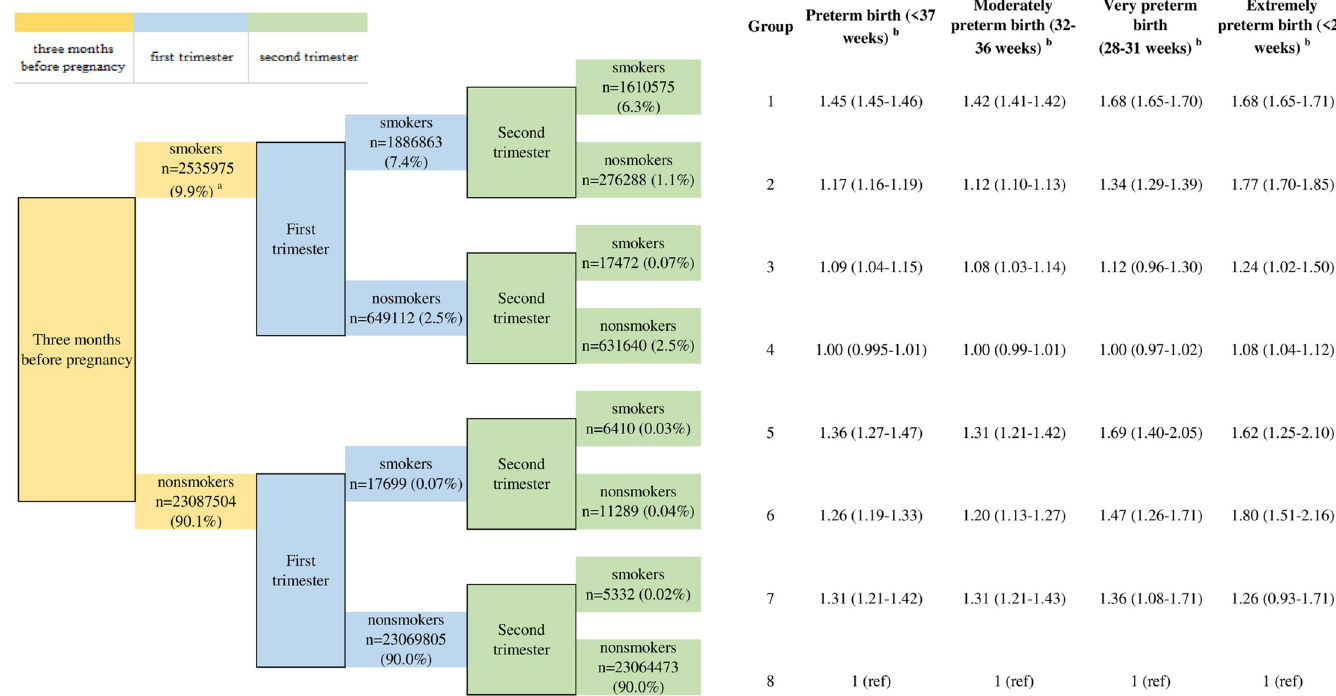
Fig 2. Association of the timing of maternal cigarette smoking with risk of preterm birth. a Number of participants and its percentage among the overall population. b The adjusted OR of preterm birth for women with different smoking patterns (groups 1–7) compared with nonsmokers (group 8). Adjustment for maternal age, race/ ethnicity, parity, education levels, prepregnancy BMI, previous history of preterm birth, marital status, infant sex, and timing of initiation of prenatal care. OR, odds ratio; ref, reference.